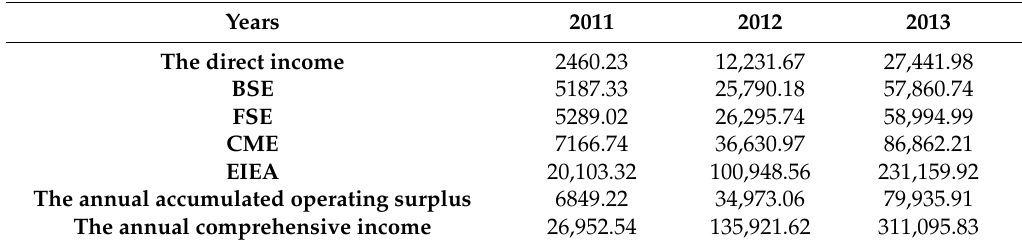
Table 6. The economic impact of ECER projects of by the ATI and comprehensive income of ECER projects of the ATI in BTH from 2011 to 2013 (ten thousand